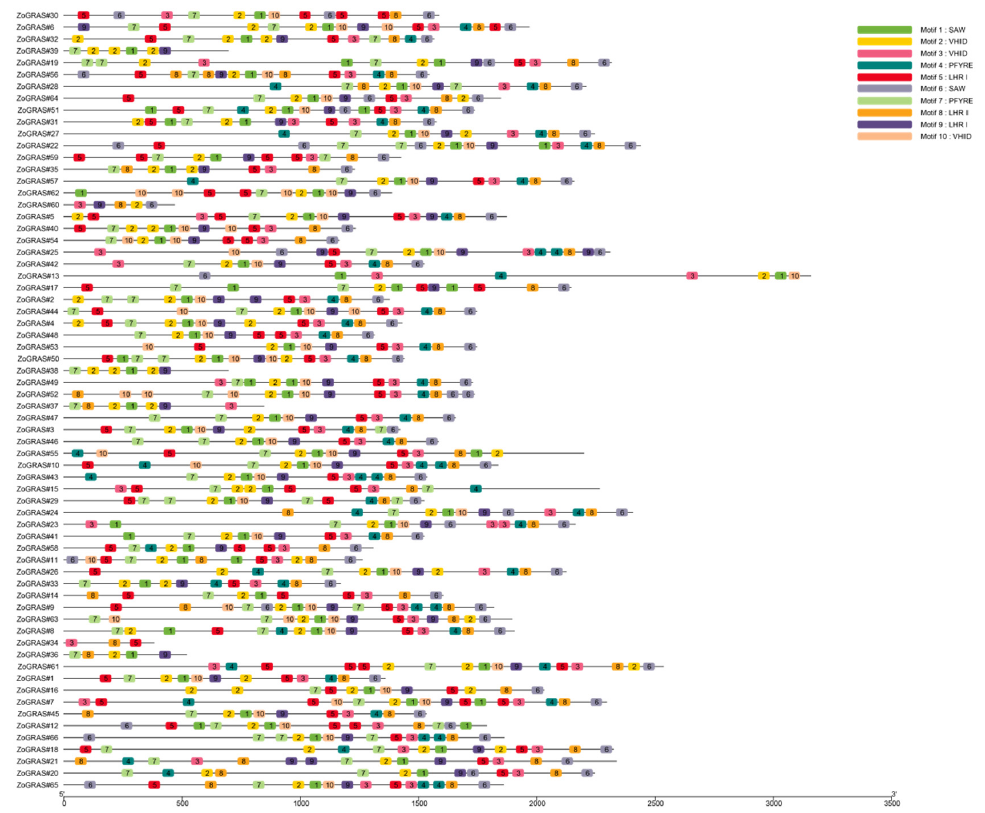
Figure 4. Motif composition of GRAS proteins in ginger. Colored boxes represent motifs detected in this study.